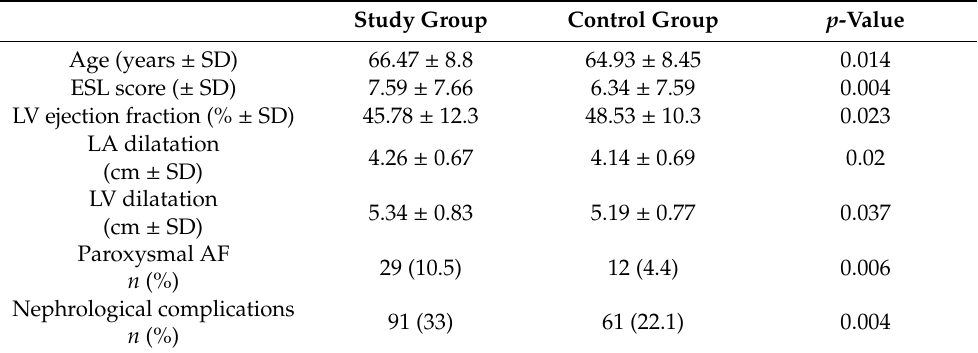
Table 4. Factors predisposing to the occurrence of postoperative cardiac complications.